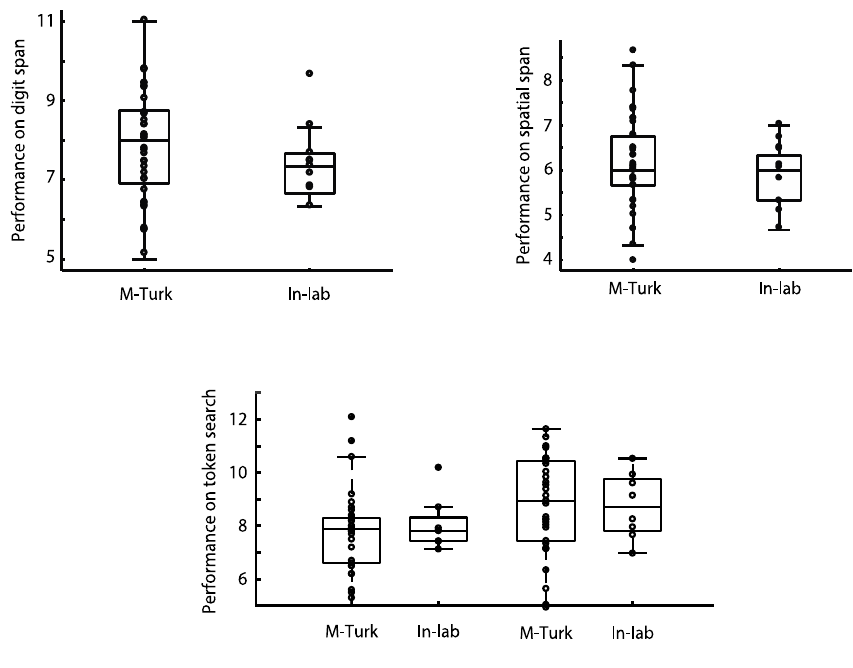
Figure 2. Average scores on 3 CBS tasks (Digit Span, Spatial Span and Token Search), taken at home and in the lab by more than 100 young adult controls. The results showed no significant effect of at home versus in laboratory testing [35]. In the case of Token Search (lower panel), the overlap in performance for participants tested at home using Amazon’s MTurk and those tested in the laboratory persisted even after several weeks of intensive training on the task [35].